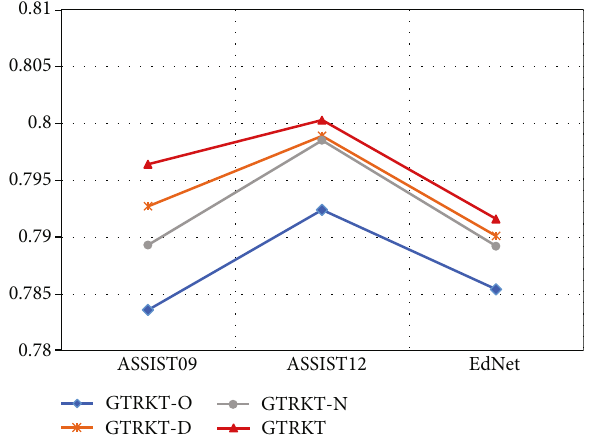
Figure 7: Comparison of di ff erent model with improved attention